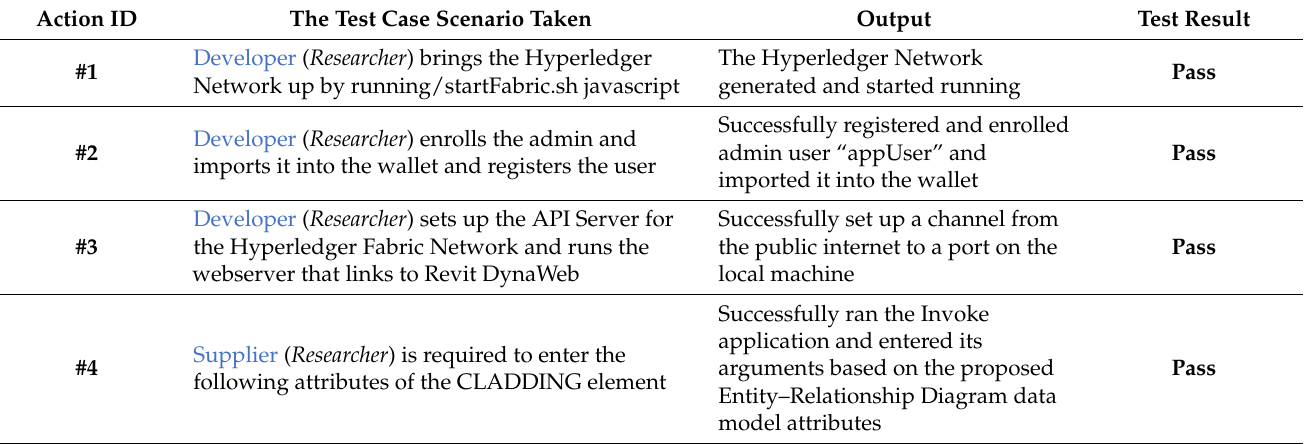
Table 2. A virtual business scenario test case and its